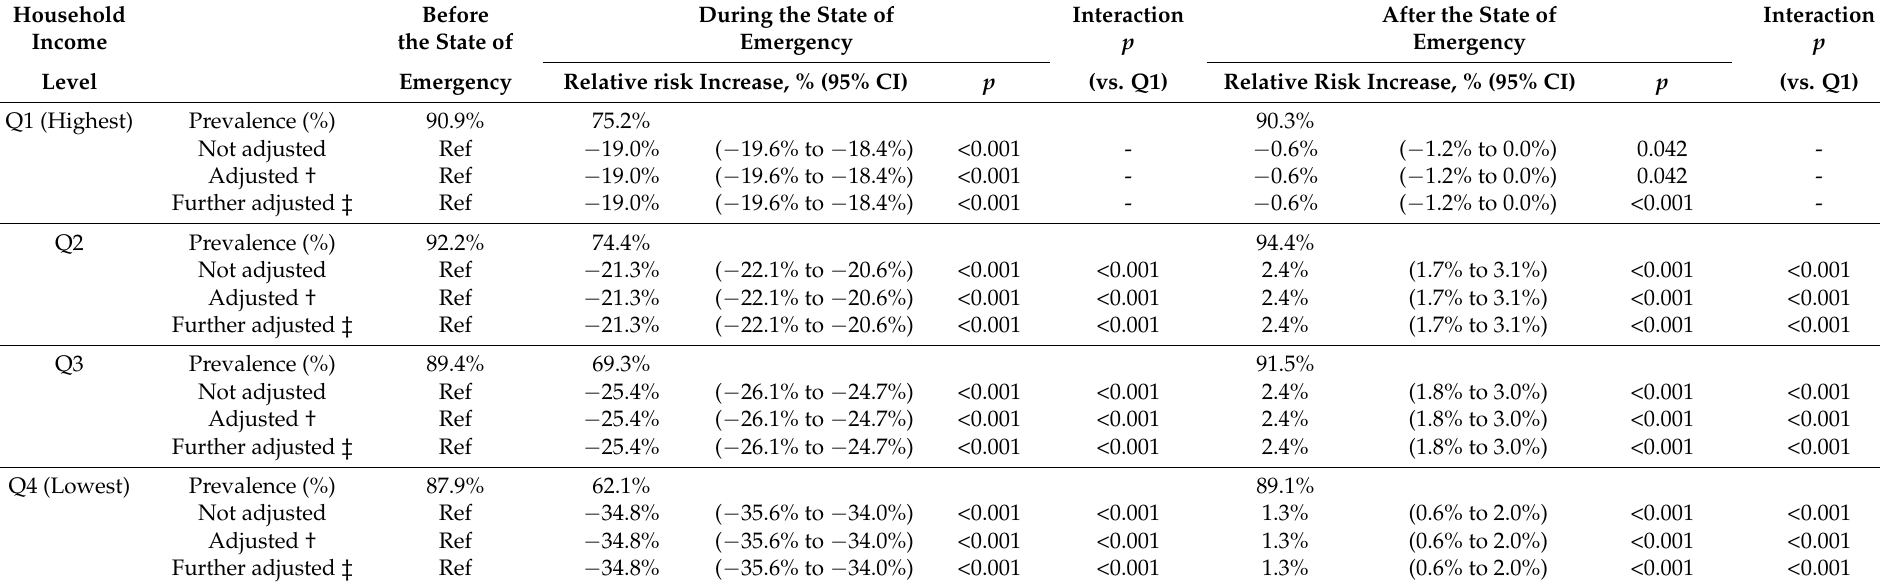
Table 4. Poisson regression analysis of household income level and prevalence of “well-balanced dietary intake” at least twice a day: 10–14-year-old schoolchildren in Japan before, during, and after COVID-19 state of